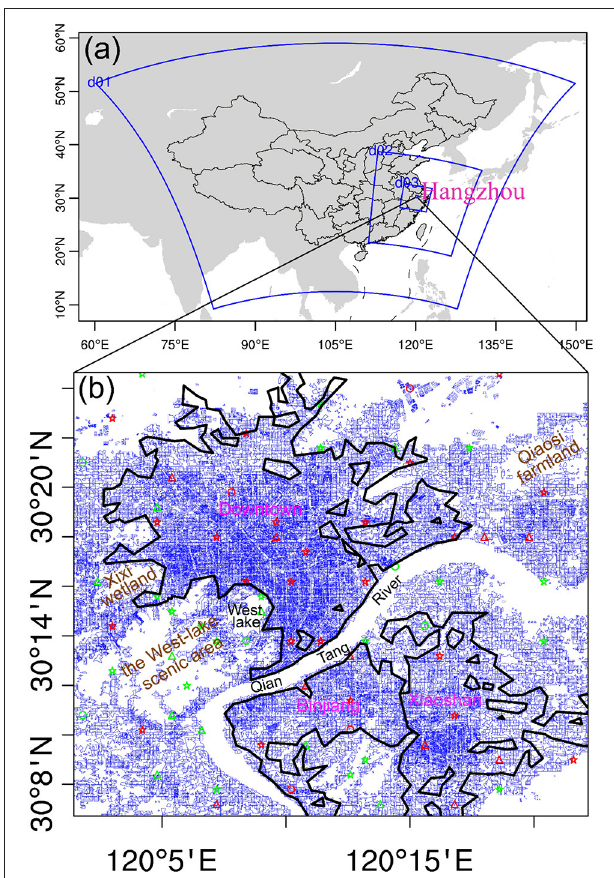
FIGURE 1 | (a) Location of Hangzhou and the configuration of one-way quadruple nested domain for Weather Research and Forecasting (WRF) simulations. (b) Schematic map of the vector-format building data (blue) with urban Automatic Weather Stations (AWS) sites (red) and rural AWS sites (green). The five-pointed star represents an AWS site with temperature, relative humidity, and wind observations; the triangle represents an AWS site with temperature and wind observations; while the circle represents an AWS site only with temperature observations. The area enclosed by the black line represents the downtown of Hangzhou and two subcenters (Binjiang and Xiaoshan), in which the impervious fraction is larger than